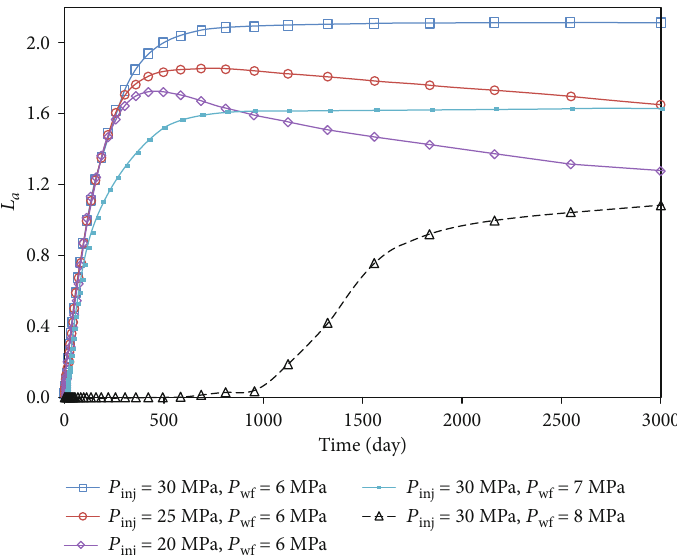
Figure 15: E ff ect of production pressure di ff erence on L